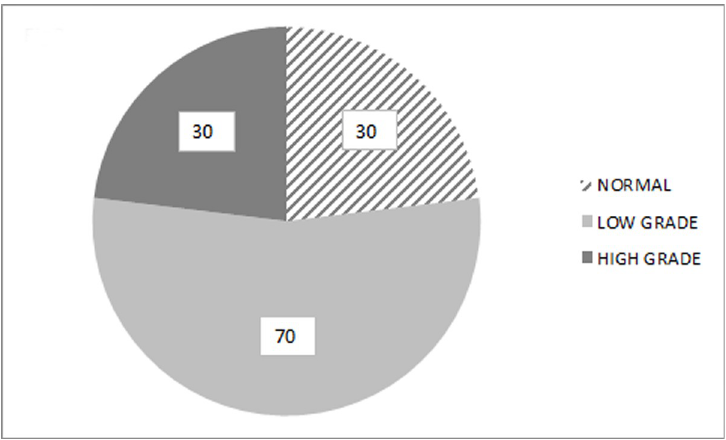
Fig 2. Percentage of normal (23.1%, n = 30), and abnormal (76.9%, n = 100)–low-grade changes (53.8%, n = 70) and high-grade changes (23.1%, n = 30) results of colposcopy